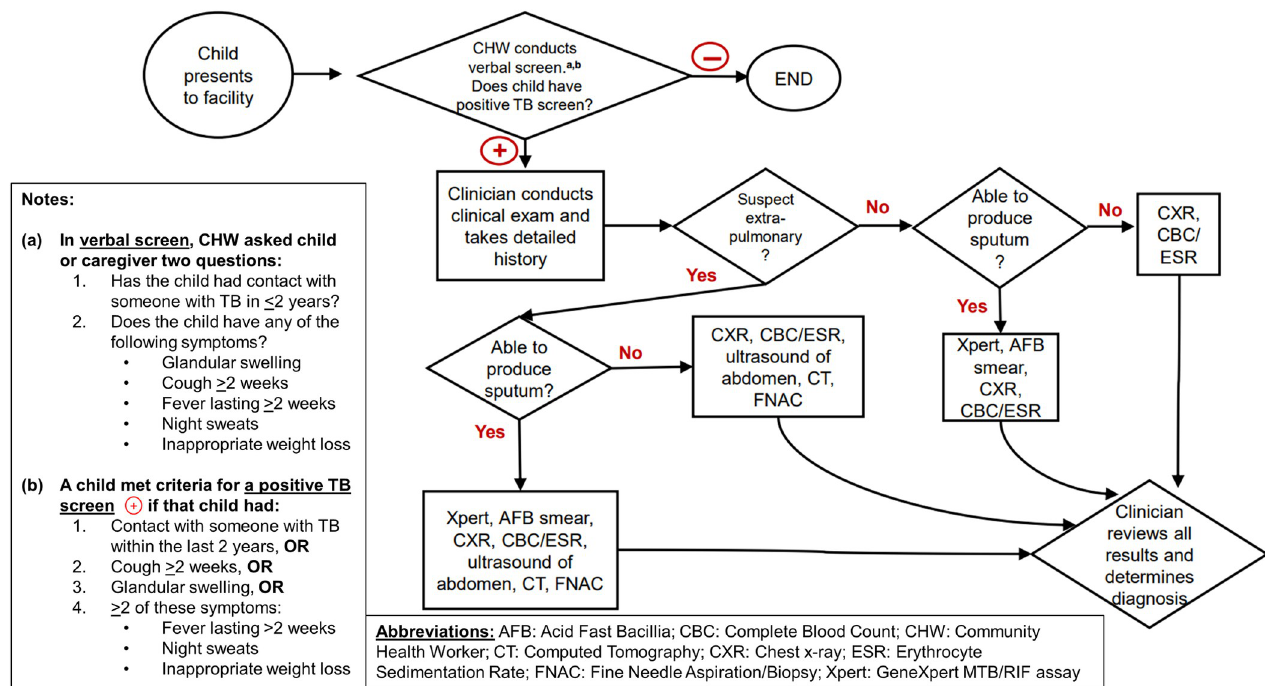
Fig 1. Process map for facility-based intervention to detect TB in